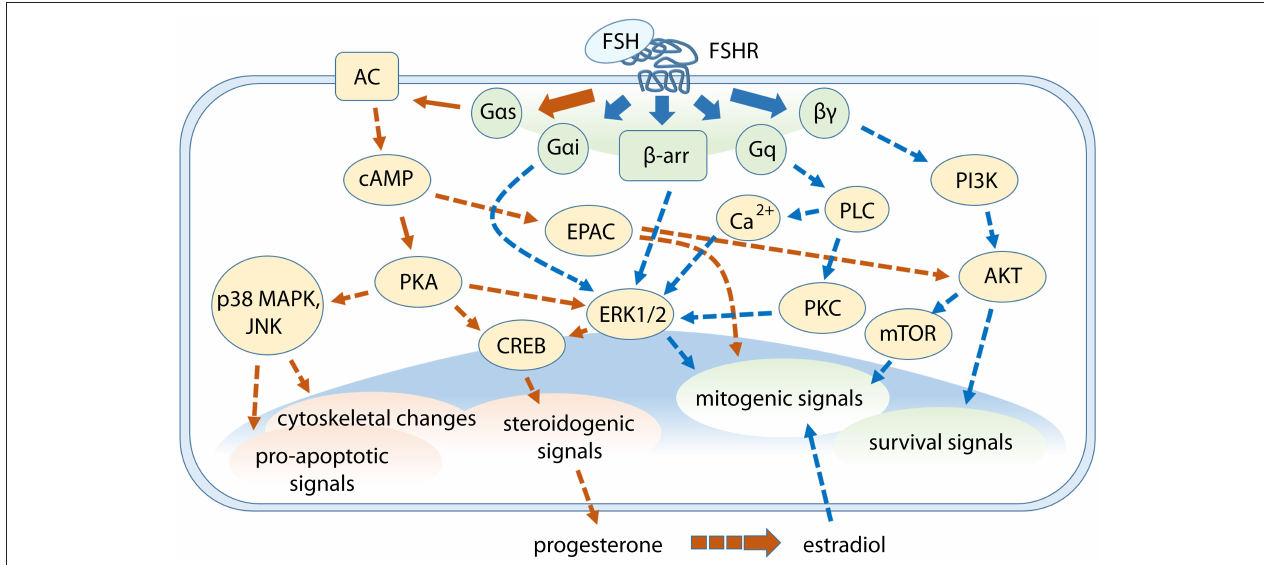
FIGURE 1 | Cross-talk between FSH-dependent steroidogenic, life, and death signals in granulosa cells. G protein subunits and β -arrestins mediate the activation of multiple signaling pathways modulating different events downstream. G α s protein/cAMP-related signaling are represented by orange arrows while signaling cascades depending on other FSHR intracellular interactors are indicated by blue arrows. Steroidogenic events are mainly mediated through cAMP/PKA-pathway, which is linked to p38 MAPK signaling, while ERK1/2 and AKT are key players for mitogenic and survival signals activation. Some pathways were